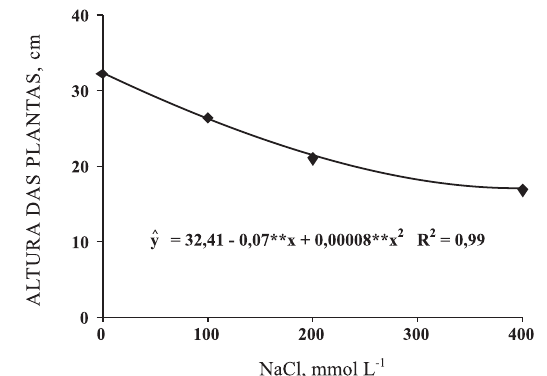
Figura 1. Altura de mudas de gliricídia em função das concentrações crescentes de NaCl na solução